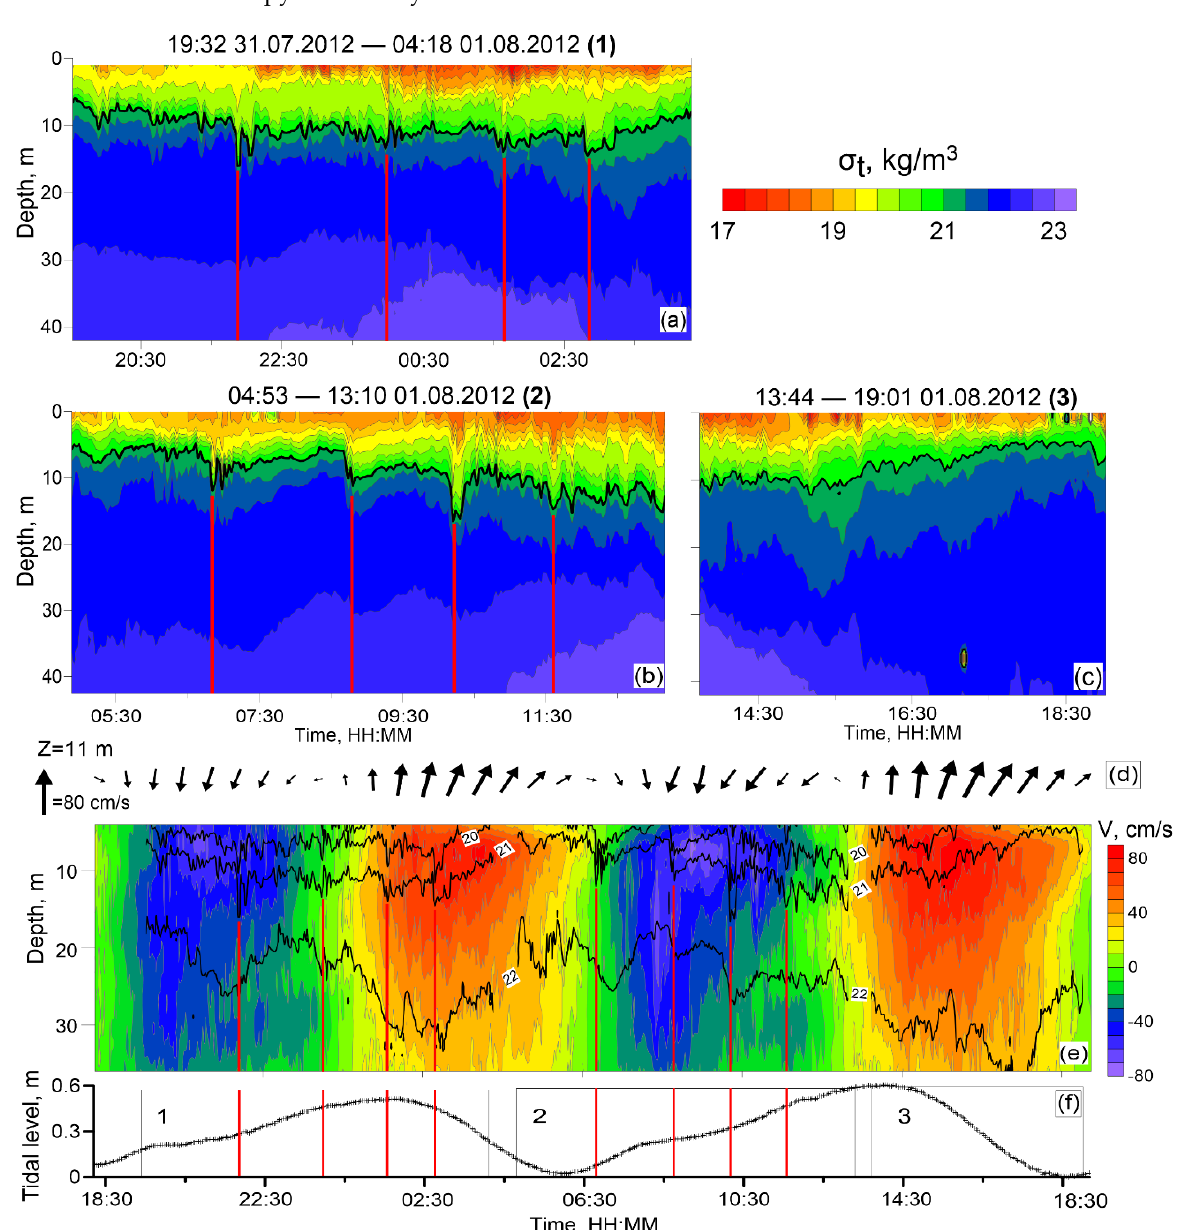
Figure 12. Hydrographic measurements at polygon 7 during a 24 h station on 31 July – 1 August 2012: ( a – c ) Vertical distribution of density anomaly from CTD casts made during time periods 1 – 3; ADCP measurements of ( d ) current speed and direction at 11 m depth. ( e ) North – south current component; ( f ) tidal level. Red vertical lines mark the time intervals when ISW trains are clearly present in the data.